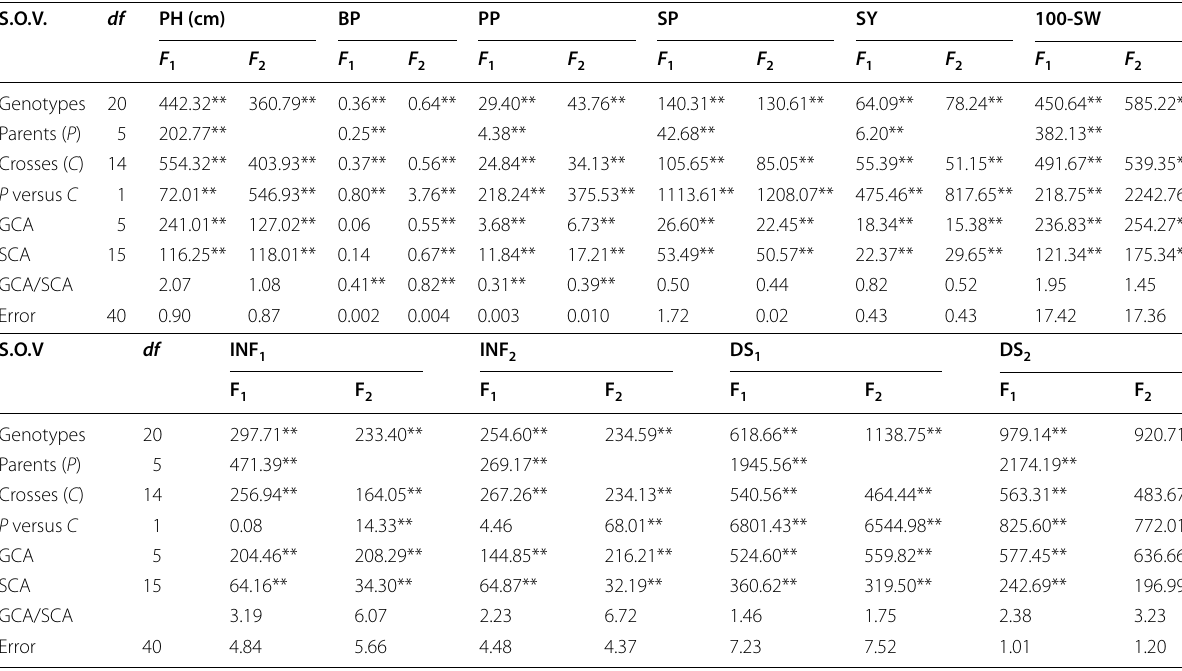
Table 2 Significance of mean squares of traits understudy